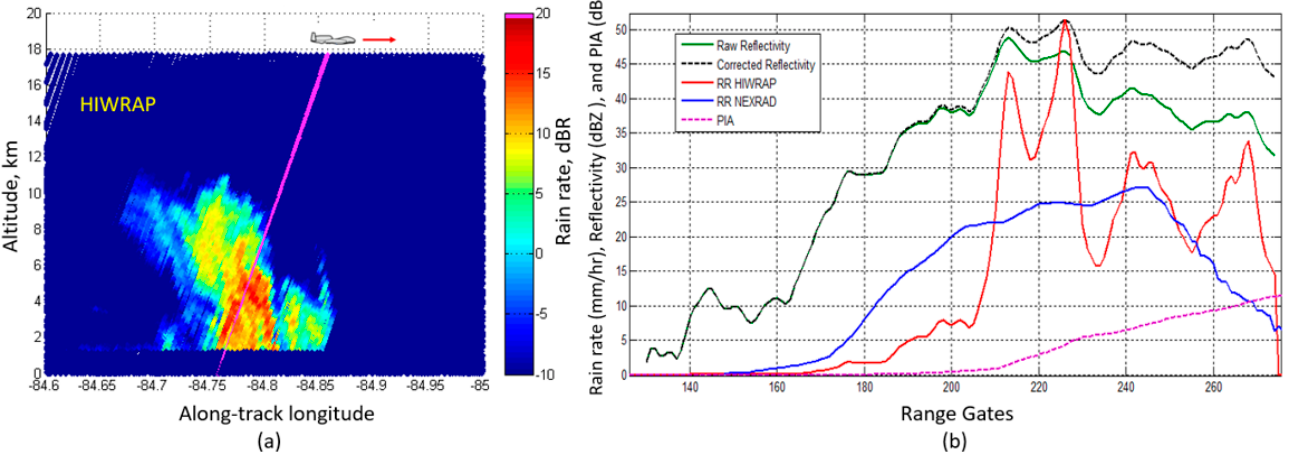
Figure 12. Single Beam Profile Comparison, where ( a ) is the HIWRAP vertical rain rate profiles from the outer beam aft looking, with the selected beam denoted by the magenta line. Panel ( b ) presents the key measured radar parameters versus RG position, where 270 is the surface RG.